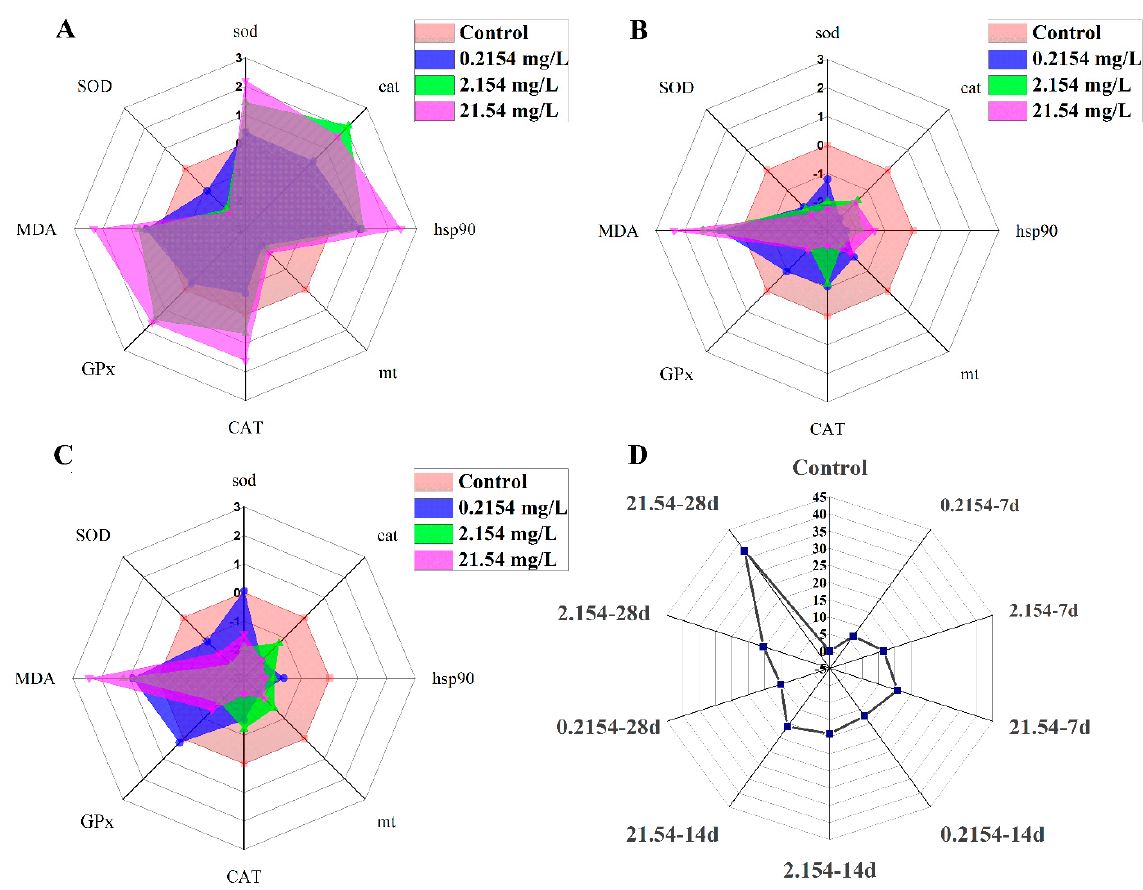
Figure 4. Star plots for measuring the various parameters of rice field eel after exposure to sulfide for 7 days ( A ), 14 days ( B ), 28 days ( C ), and IBR values for each treatment ( D ). Control, control group; 0.2154 − 7d, 0.2154 mg/L Na 2 S exposed for 7 days; 2.154 − 7d, 2.154 mg/L Na 2 S exposed for 7 days; 21.54 − 7d, 21.54 mg/L Na 2 S exposed for 7 days; 0.2154 − 14d, 0.2154 mg/L Na 2 S exposed for 14 days; 2.154 − 14d, 2.154 mg/L Na 2 S exposed for 14 days; 21.54 − 14d, 21.54 mg/L Na 2 S exposed for 14 days; 0.2154 − 28d, 0.2154 mg/L Na 2 S exposed for 28 days; 2.154 − 28d, 2.154 mg/L Na 2 S exposed for 28 days; 21.54 − 28d, 21.54 mg/L Na 2 S exposed for 28 days.